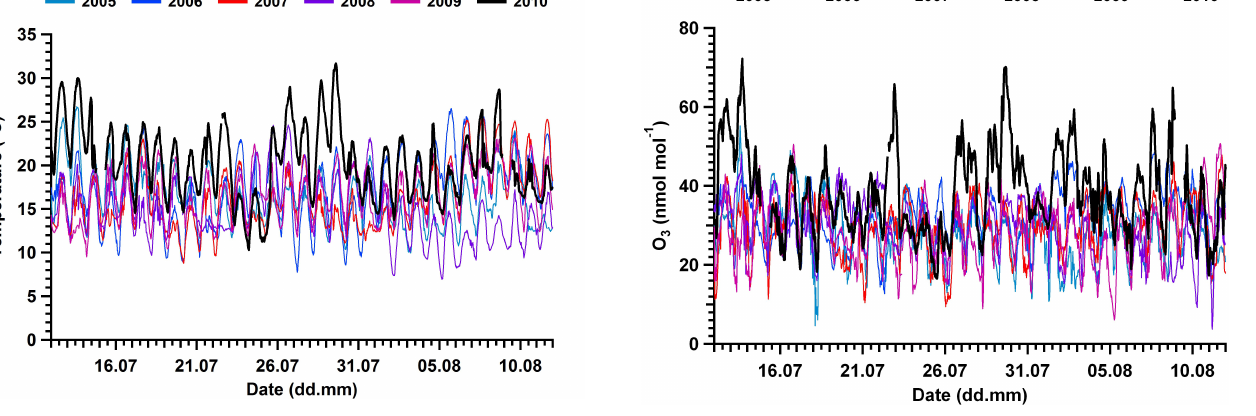
Fig. 2b. Ozone (30min average) recorded in Hyyti¨al¨a between July and August from 2005–2009 from mast at 16.8m and 2010 from